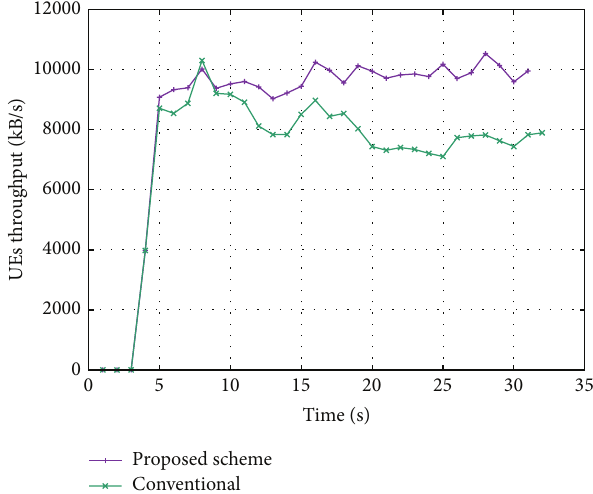
Figure 13: Overall system throughput comparison proposed scheme and conventional